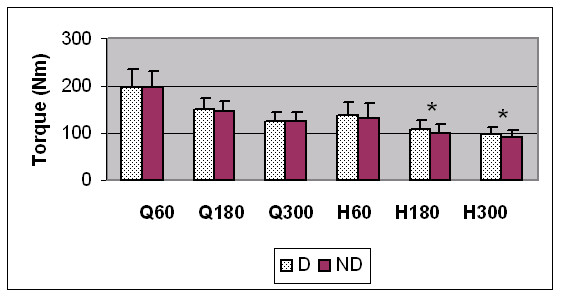
Comparison of quadriceps (Q) and hamstrings (H) average peak torque values for dominant (D) and non-dominant (ND) uninjured subjects (n = 29) at 60°/sec, 180°/sec and 300°/sec. * indicates a statistically significant difference (p < 0.05).